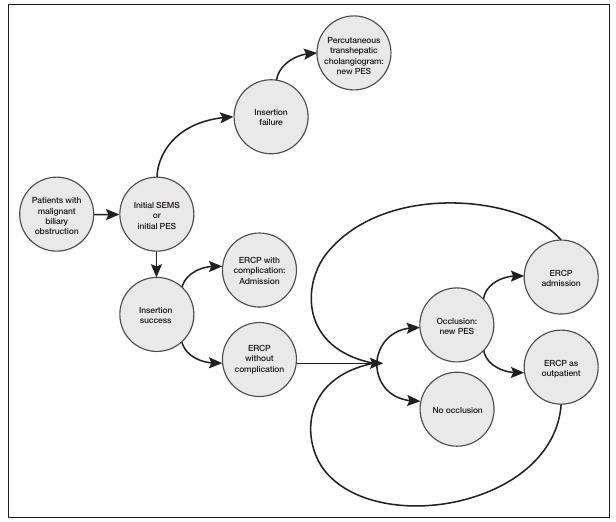
Figure 1) Influence diagram of the adopted model structure. ERCP Endoscopic retrograde cholangiopancreatography; PES Polyethylene stent; SEMS Partially covered self-expandable metal